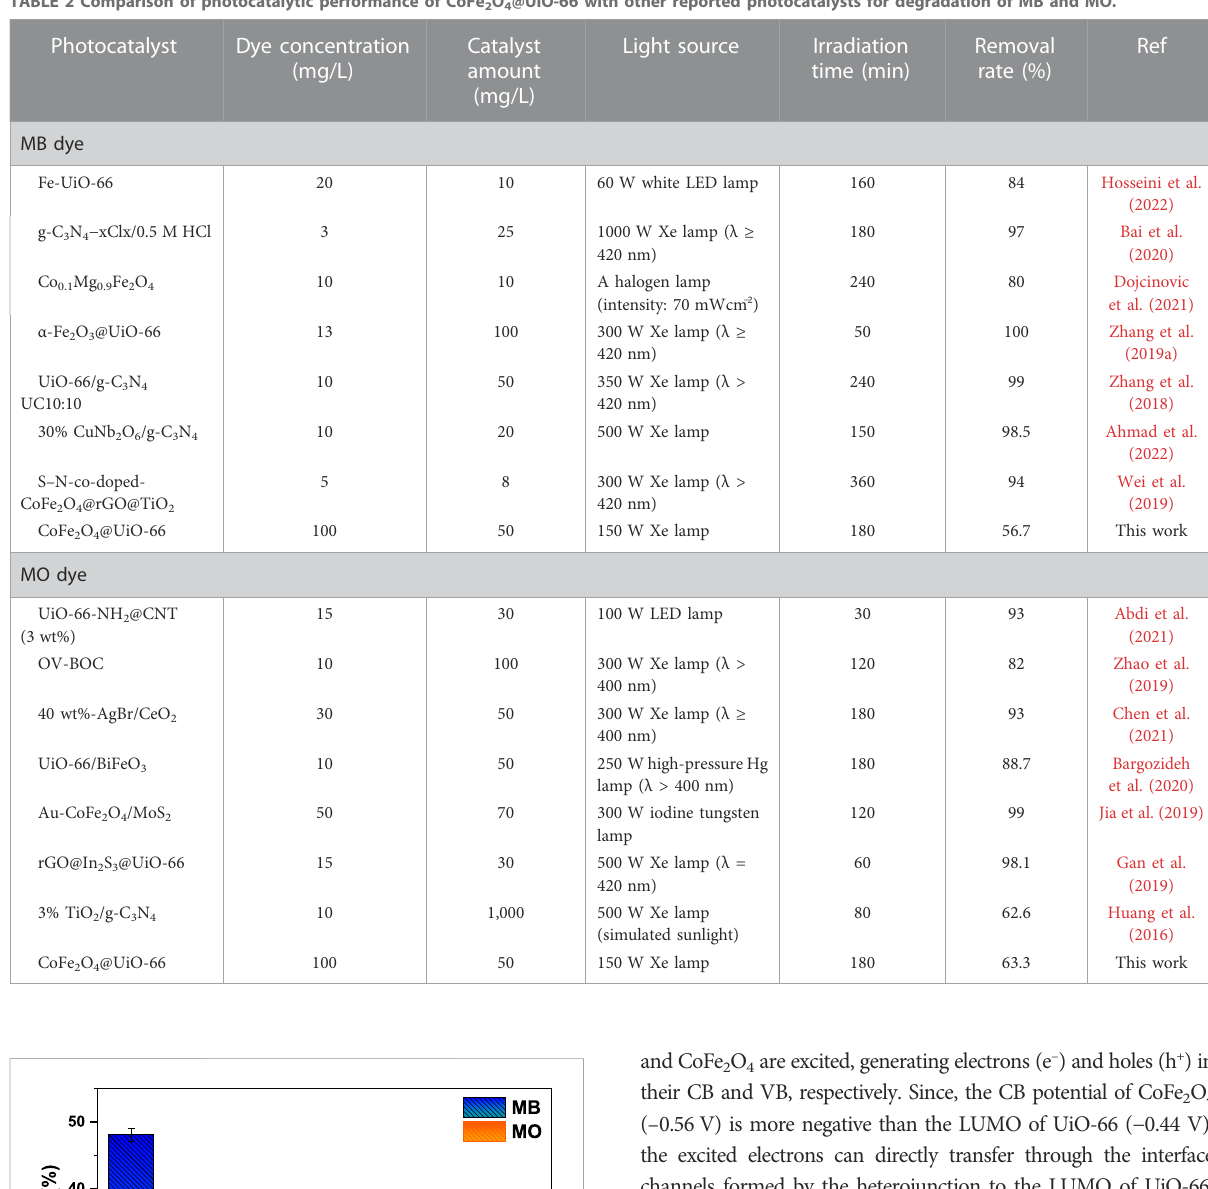
TABLE 2 Comparison of photocatalytic performance of CoFe 2 O 4 @UiO-66 with other reported photocatalysts for degradation of MB and MO. Photocatalyst